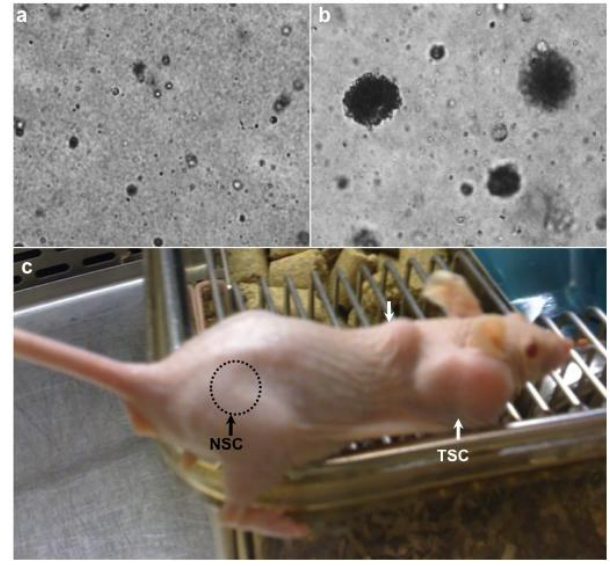
Figure 4. Anchorage-Independent growth and subcutaneous xenografts of GBM stem cells. ( a ) and ( b ) compare normal neurospheres to GBM stem cells, which aggressively develop cell aggregates in 3D experimental system. Tumorigenicity in vivo was accomplished when GBM stem cells were injected subcutaneously into the athymic mice ( c